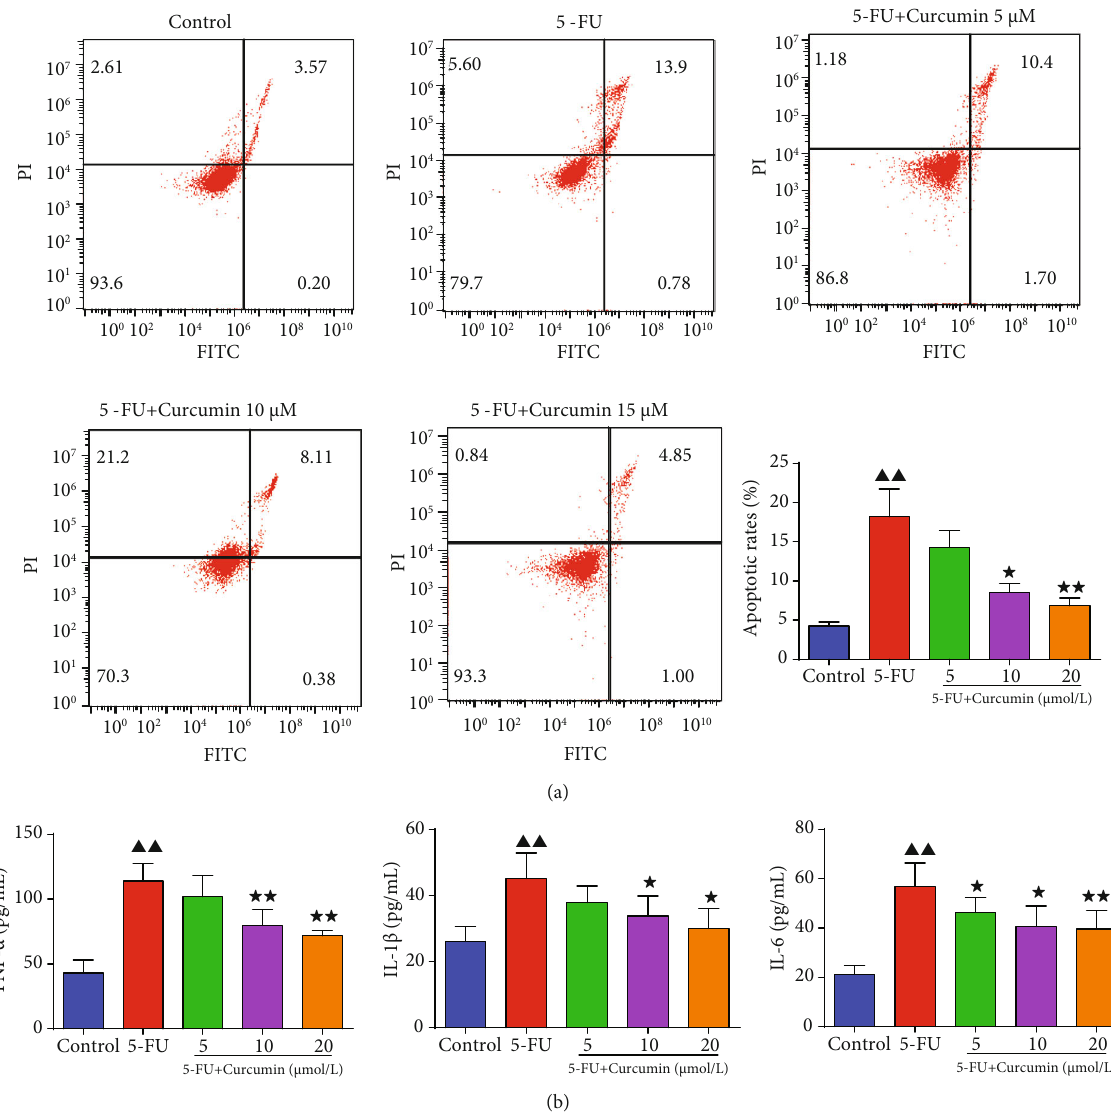
Figure 2: E ff ect of curcumin on the apoptosis and in fl ammation of the 5-FU-stimulated IEC-6 cells. IEC-6 cells were stimulated with 5-FU for 24 h and then further treated with curcumin at 5, 10, and 20 μ mol/L for 24h. (a) Flow cytometry assay was performed to detect the cell apoptosis of each group cells. (b) The levels of TNF- α , IL-1 β , and IL-6 were detected using ELISA kits. Data were expressed as mean ± standard errormean (SEM), ▲▲ p value < 0.01 vs. control group; ∗ p value < 0.05 vs. 5-FU group; ∗∗ p value < 0.01 vs. 5-FU group. 5-FU: 5- fl